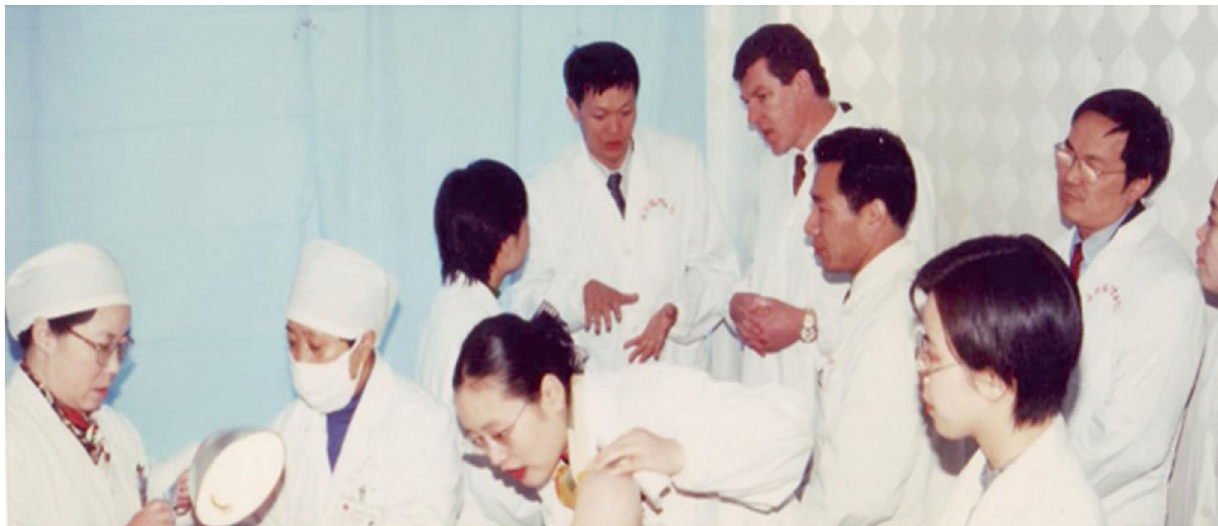
Figure 5. Dr. Jian Zhou (5th from the left) and Professor Ian Frazer (5th from right) at the fi rst af fi liation hospital of Wenzhou Medical